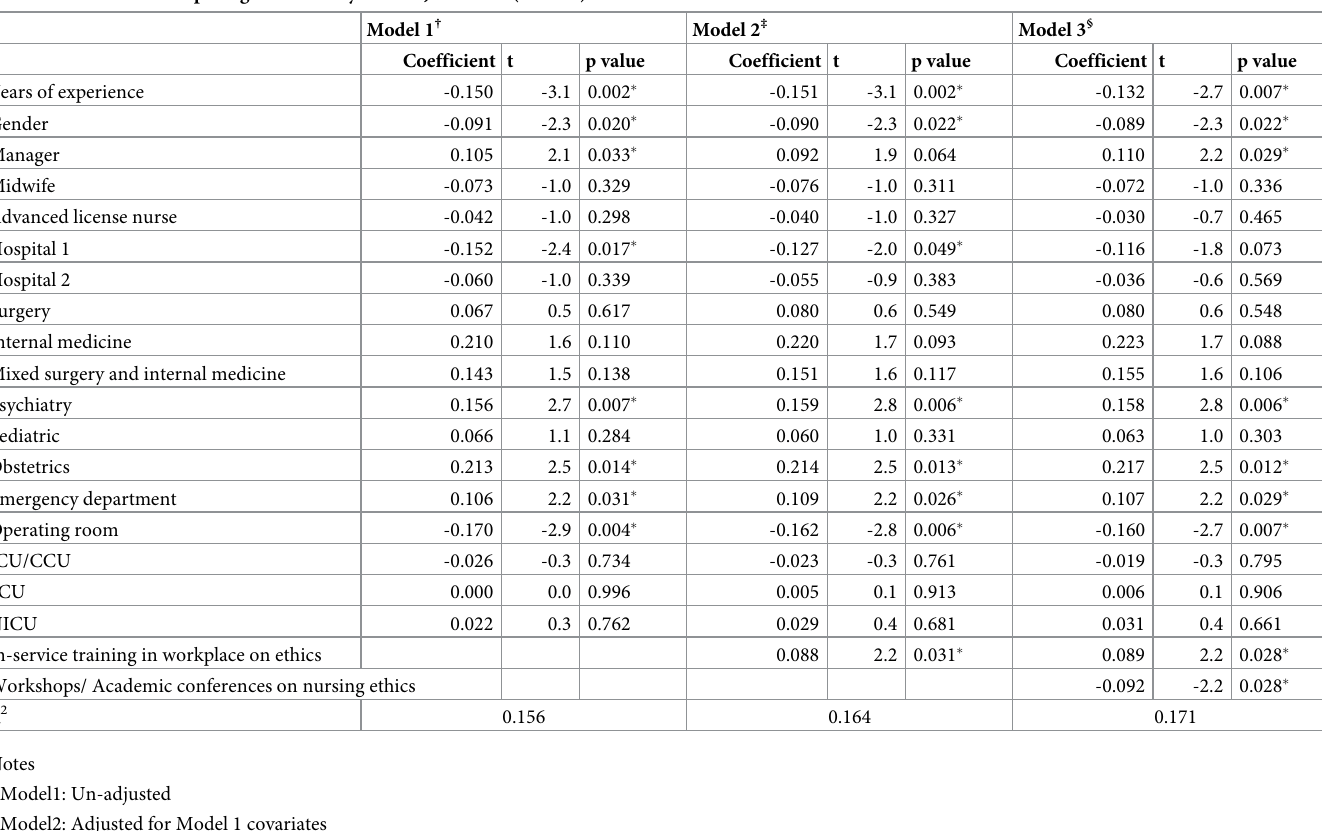
Table 4. Results of multiple regression analysis with J-HECS26 (n = 604).